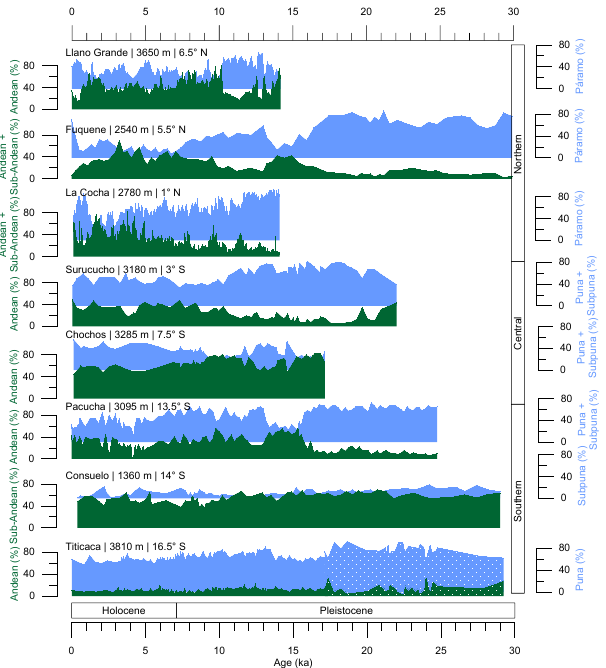
Figure 2. Summary pollen diagrams of selected pollen records from the tropical Andes (Fig. 1, Table 1) plotted in latitudinal or- der against time in thousands of years (ka). Site name, elevation rounded up to the nearest 5m, and latitude to the nearest half degree are shown next to each record. Pollen taxa are grouped into Andean and sub-Andean taxa (green) and páramo, puna, or subpuna taxa (blue). Taxa groupings follow original papers when available. For sites published without ecological groups, taxa have been grouped for the first time. Two pollen records are available from Lake Titi- caca, and here they are differentiated with a dotted pattern for the Hanselman et al. (2011) record and a solid pattern for the Paduano et al. (2003) record.